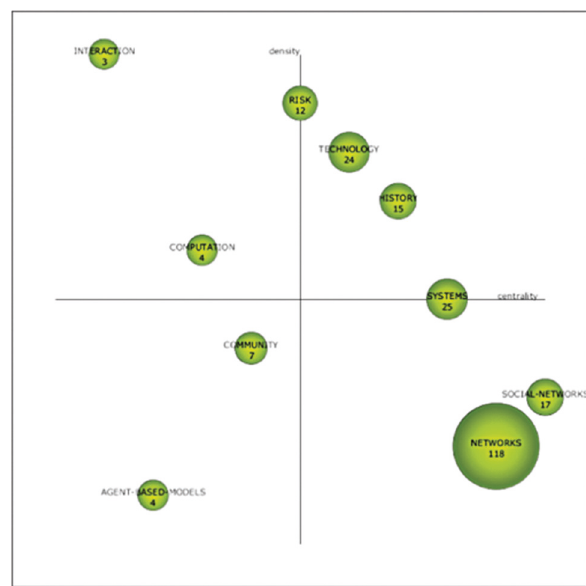
Figure 19: 2016–2020 strategic coordinate